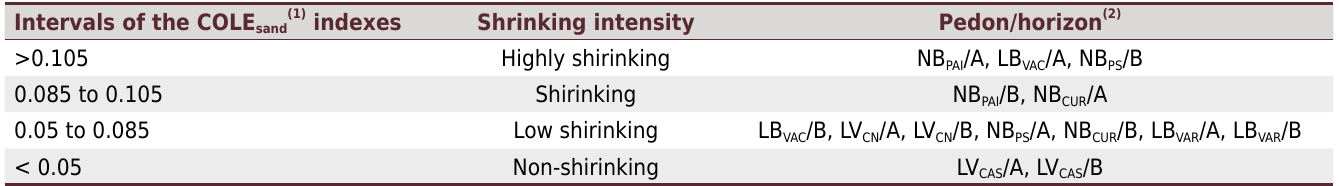
COLE sand : coefficient of linear extensibility obtained by the Ring with Sand Method. (2) NB PAI : Nitossolo Bruno , located in Painel/SC; LB VAC : Latossolo Bruno , located in Vacaria/RS; NB PS : Nitossolo Bruno , located in Ponte Serrada/SC; LV CN : Latossolo Vermelho , located in Campos Novos/SC; NB CUR : Nitossolo Bruno , located in Cutitibanos/SC; LB VAR : Latossolo Bruno , located in Vargeão/SC; LV CAS : Latossolo Vermelho , in